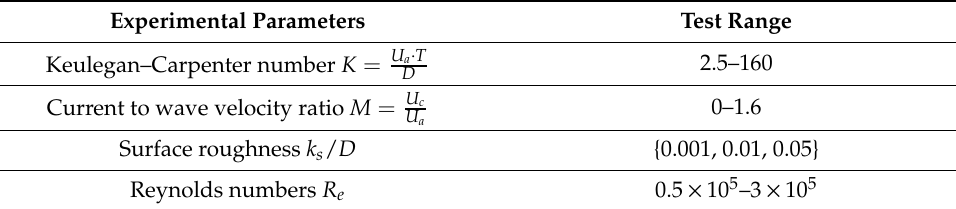
Table 1. Range of experimental parameters.